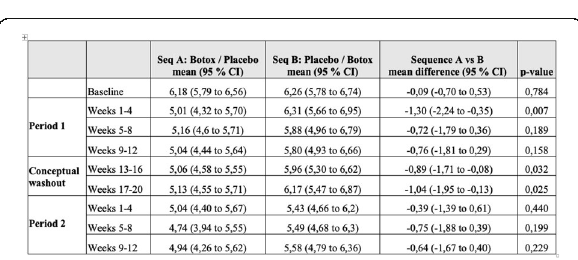
Fig. 2 (abstract P283). Primary outcome (pain intensity measured on a numerical rating scale) demonstrated by treatment sequence A and B